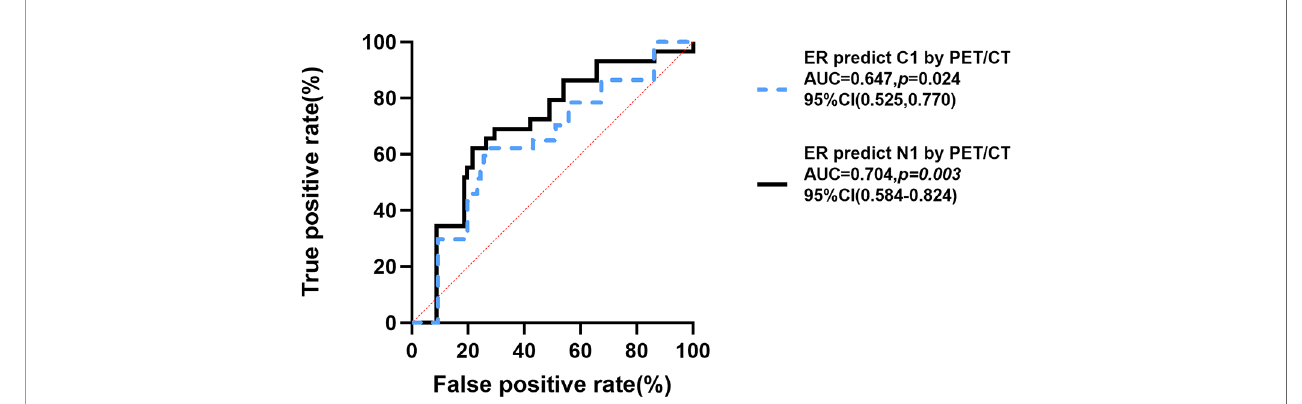
FIGURE 3 | ROC curve for proportion of ER-positive expression predicting C1 and N1. Youden Index of N group and C group =25%. N1, extraaxillary lymph node metastasis; C0, no unsuspected metastasis; C1, unsuspected metastasis and with initial treatment plan changed; ER, estrogen receptor; ROC, Receiver Operating Characteristic; AUC, area under curve; CI, con fi dence interval. P < 0.05 was considered signi fi cant.